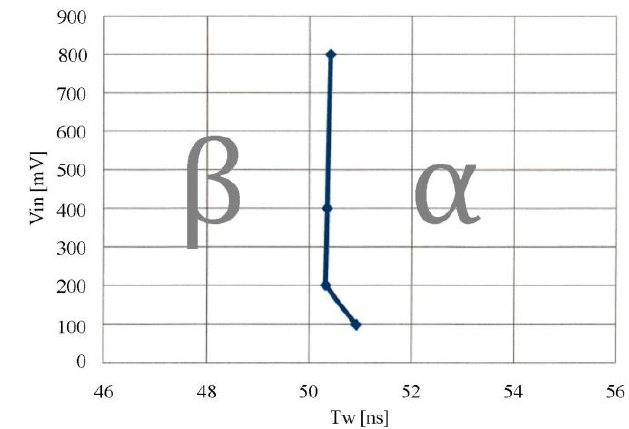
Fig. 6. Measured results for the vertical classification line in the height – time span produced by the time duration PSD topology.